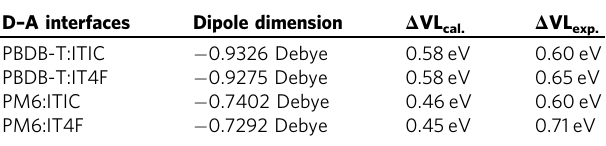
Table 3 Summary of the calculated dipole dimensions for donor (D) – acceptor (A) interfaces of face-on/face-on orientation, calculated vacuum level potential steps ( Δ VL cal. ), and the ones measured from UPS experiments ( Δ VL exp.